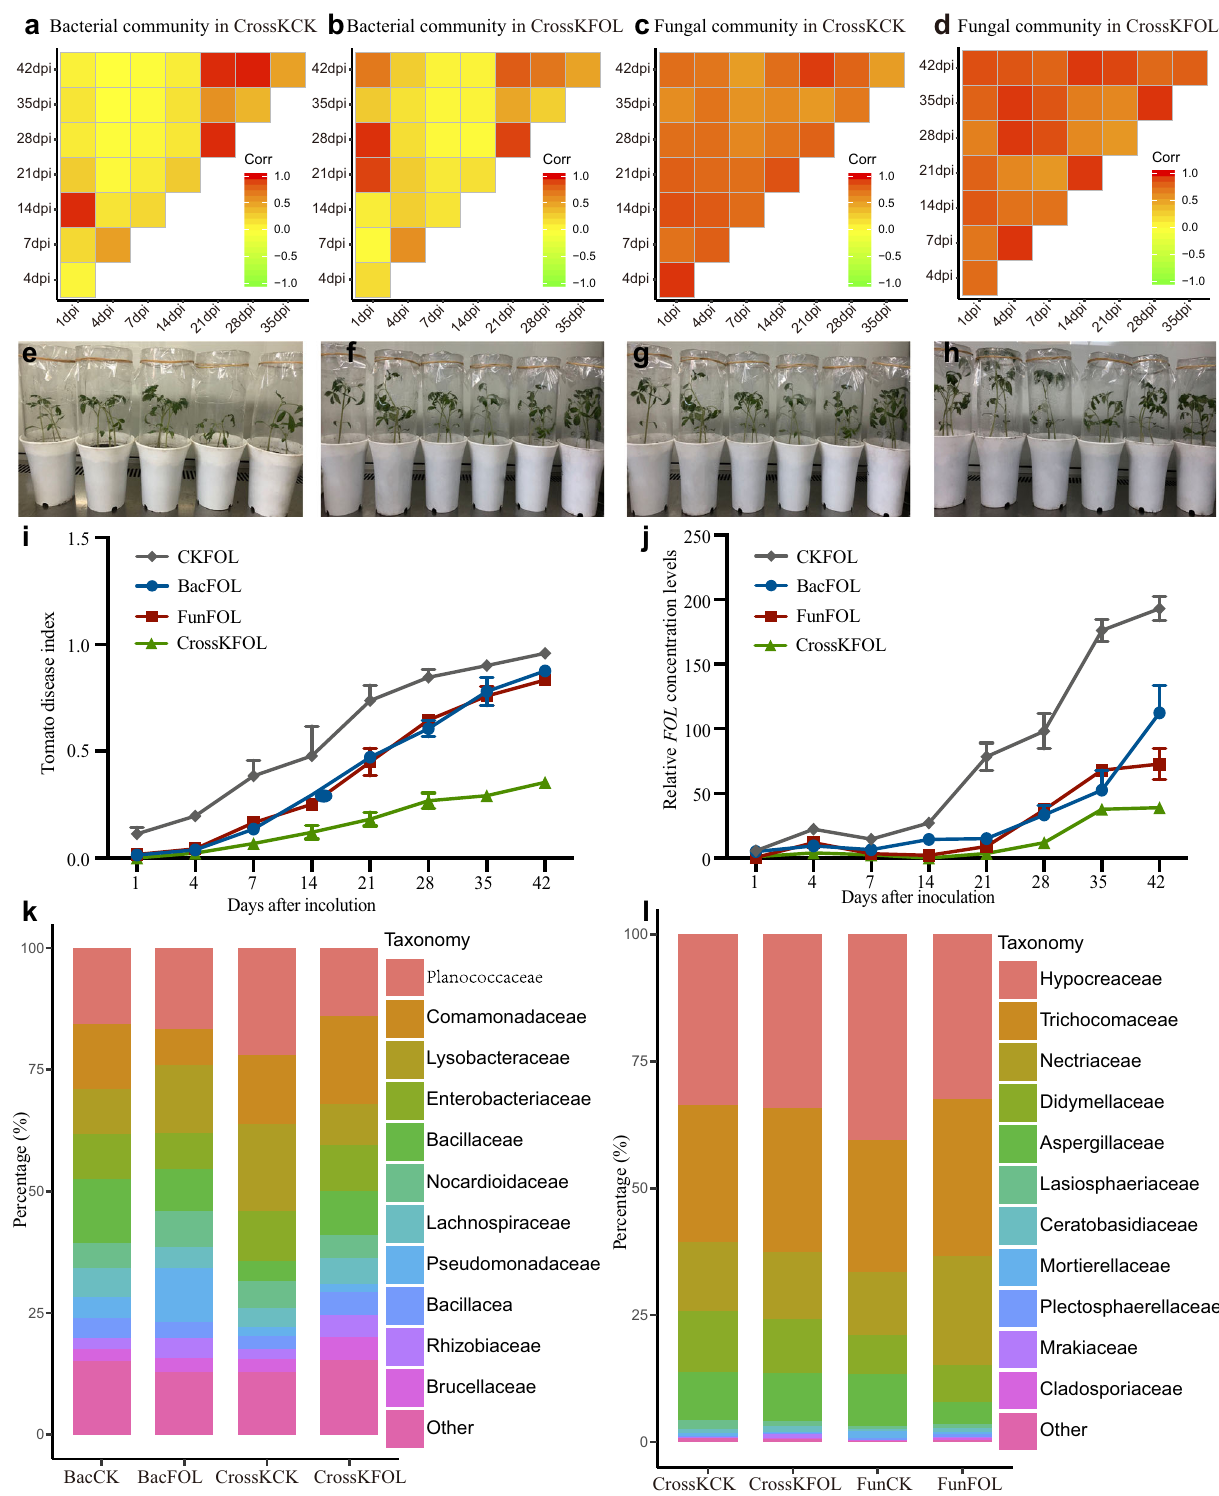
expressionofthe PR1 α and LOX genesindifferentSynComsgroupsat different time periods. Compared with the CK treatment, PR1 α